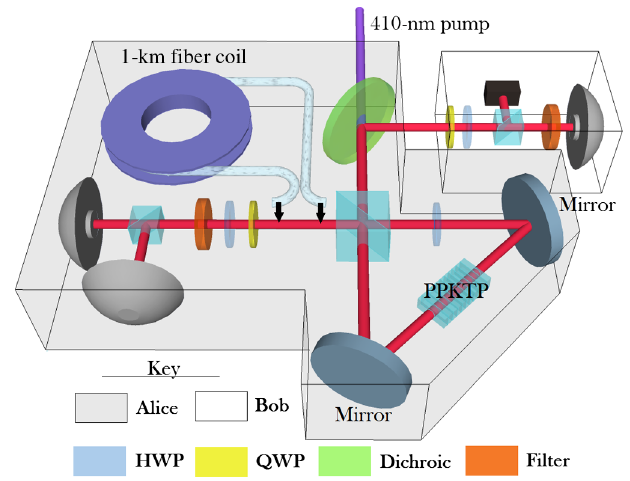
FIG. 4. Schematic drawing of the experimental apparatus for demonstrating EPR-steering with no detection loophole. Bob’s apparatus is contained within the white box, while everything else, including the source, is assumed by Bob to be Alice’s (gray box), per Fig. 1. A 410-nm 1-mw CW laser pumps a 10-mm-long periodically poled potassium titanyl phosphate (PPKTP) crystal, creating the maximally entangled singlet state at 820 nm. quarter-wave plates (HWP and QWP), mounted in motorized rotation stages, relative to the axes of polarizing beam splitters (PBSs, blue cubes). After filtering (Bob, 2-nm interference filter; Alice, long pass filter), photons are coupled to single-mode fibers leading to single-photon-counting modules and counting elec- tronics. For some experiments, we insert a 1-km fiber coil between Alice’s detection apparatus and the source. Because Bob trusts his own apparatus, it is sufficient for him to use only one detector (gray hemisphere), corresponding to one (varied at random) of the two eigenstates of his observable ^ (cid:1) B k . For further details, see Appendix